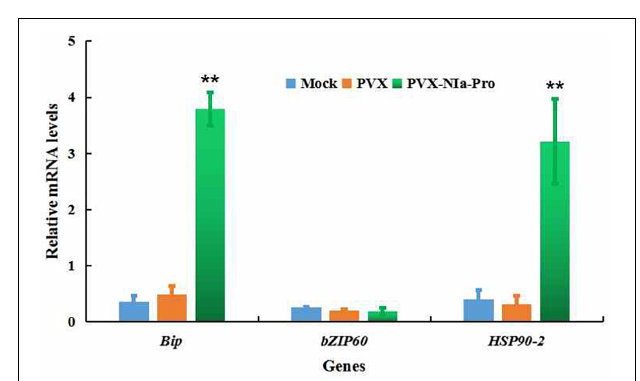
FIGURE 4 | Relative mRNA levels of the indicated endoplasmic reticulum (ER) stress marker genes in NIa-Pro-expressing Nicotiana benthamiana plants as determined by qRT-PCR. Relative mRNA levels of N. benthamiana ER-localized binding ( Bip ), Heat shock 90-2 ( HSP90-2 ), and basic leucine zipper 60 ( bZIP60 ) were measured in potato virus X (PVX)-NIa-Pro and PVX vector-infected N. benthamiana plants at 20 days post inoculation (dpi). Values are the mean ± SD. Highly significant differences ( ** p < 0.01) between samples in each pair are indicated.